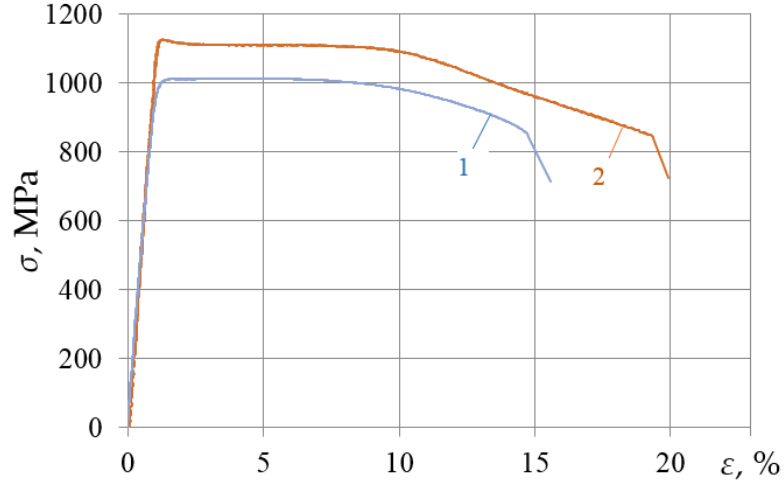
Figure 4. Stress–strain diagrams of the VT23 alloy after the DNP: 1—transverse direction of rolling, ε і mp = 1.44%; 2—longitudinal direction of rolling, ε і mp = 1.5% [36].